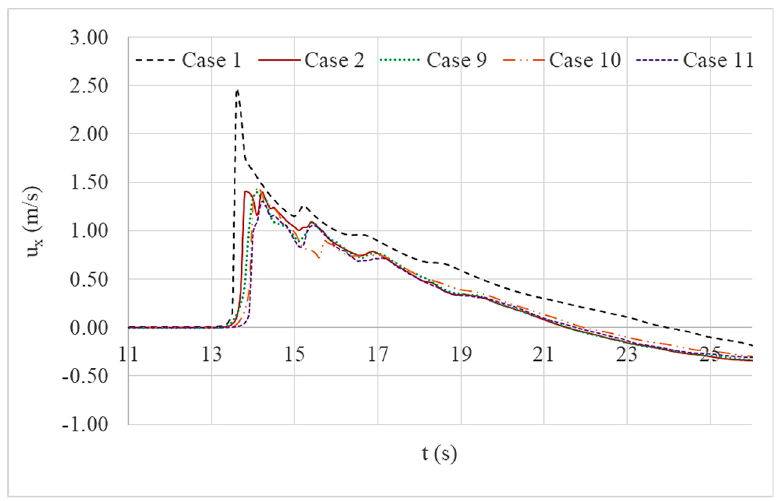
Figure 14. Comparison of current velocity (x-component) variations at location D.